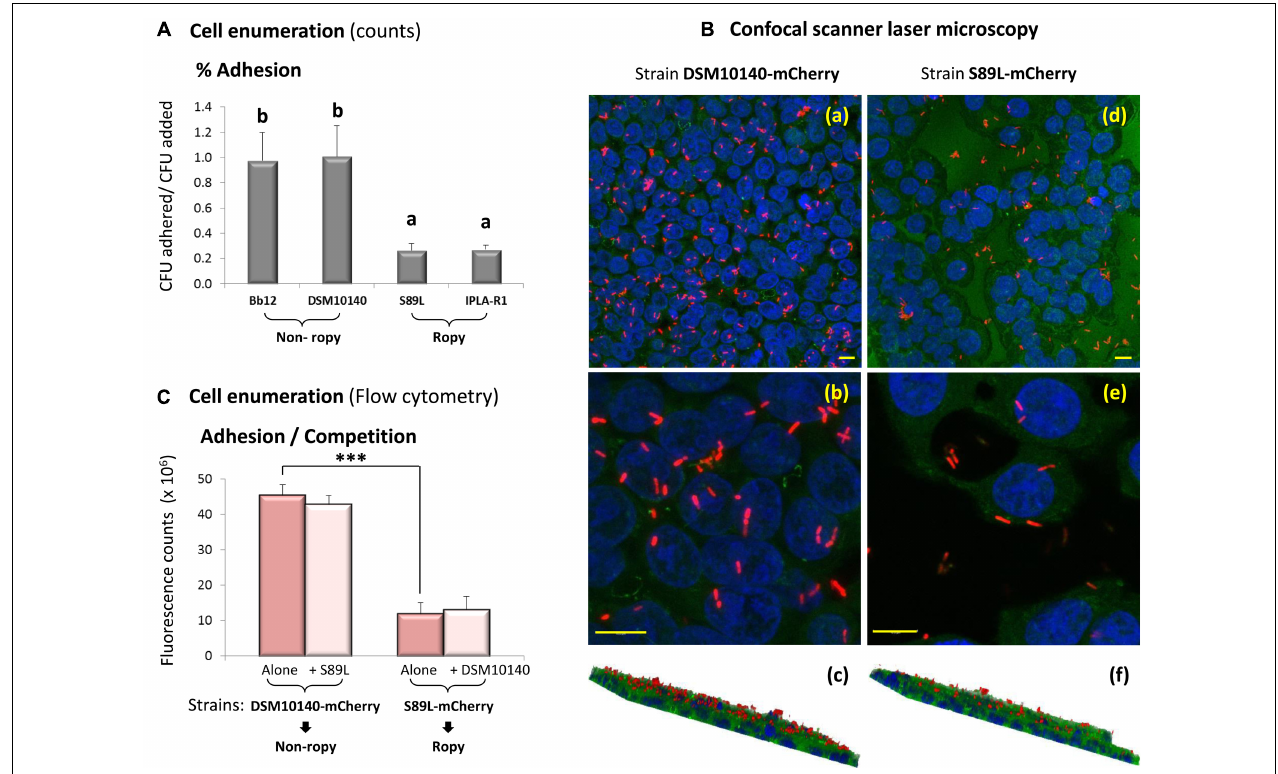
FIGURE 4 | Adhesion to the intestinal cell line HT29 of four B. animalis subsp. lactis strains: DSM10140 and Bb12 display a non-ropy phenotype and S89L and IPLA-R1 display a ropy phenotype. Bars that do not share a common letter are statistically ( p < 0.05) different (A) . Visualization of DSM10140-mCherry (a, b, and c) and S89L-mCherry (d, e, and f) strains adhered to HT29 using the TCS SPE confocal module of the Leica DMi8 inverted microscope (bars 10 µ m). The nucleus was DAPI-stained in blue (excited at 405 nm), the green color corresponds with the auto-fluorescence emitted by cytoplasmic molecules of the cell line, and the fluorescent bifidobacteria were detected in red (excited at 561 nm). The bottom photographs (c and f) represent a rotated 3D-image obtained from the Z- projection (10-XY slides, thickness about 13–15 µ m) showing the integrity of the HT29 monolayer covered by a “grass” of fluorescent B. animalis subsp. lactis strains (B) . Adhesion to HT29 of strains DSM10140-mCherry and S89L-mCherry (red bars) quantified by means of flow cytometry; statistical difference between both strains are indicated with asterisks ( p < 0.01). The pink bars show the adhesion of the fluorescent strains in competition with the non-fluorescent counterpart strains (C)